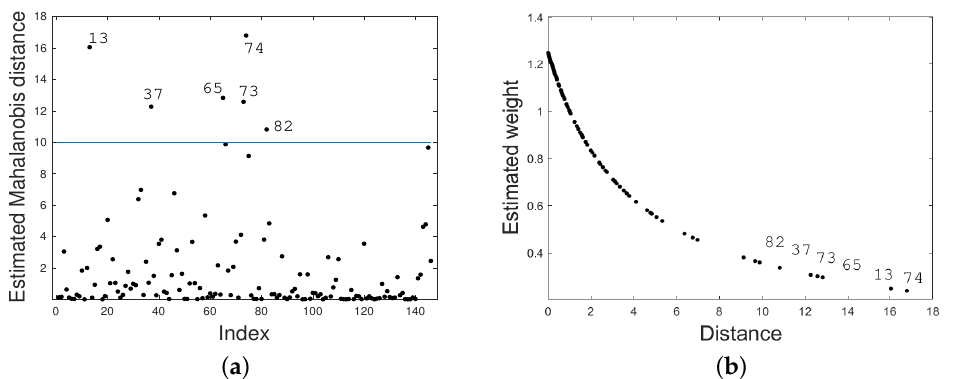
Figure 6. Index plots of the Mahalanobis distance ˆ δ i ( a ) and the estimated weights ˆ δ i ( b ) for Student-t PVCM (Santiago